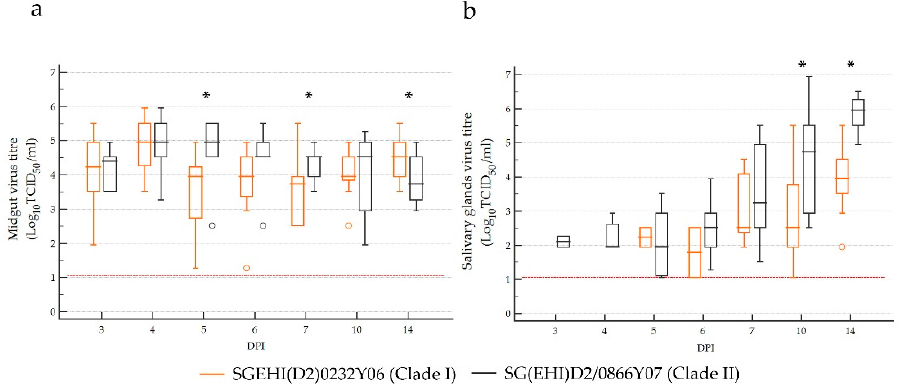
Figure 6. Ae. aegypti midgut ( a ) and salivary gland ( b ) virus titers at different timepoints following oral infection with clade I and II isolates. The central box represents the values from the lower to upper quartile (25 to 75 percentile). The middle line represents the median. The horizontal line extends from the minimum to the maximum value, excluding far-out values, which are displayed as separate points. Asterisks indicates a p -value of <0.05 by the Mann–Whitney U test between the two clades. The limit of detection is represented by the red dotted line.